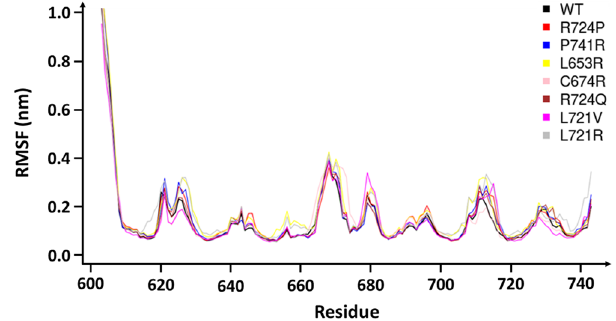
Figure 5. Calf-1 RMSF of the different systems. By comparison, Calf-1 variant structures mainly behaved like the WT form (black curve). The noisy peaks for the N-ter first residues were discarded in the majority of the analyses since, in nature they lay at conjunction to the neighbouring domain.